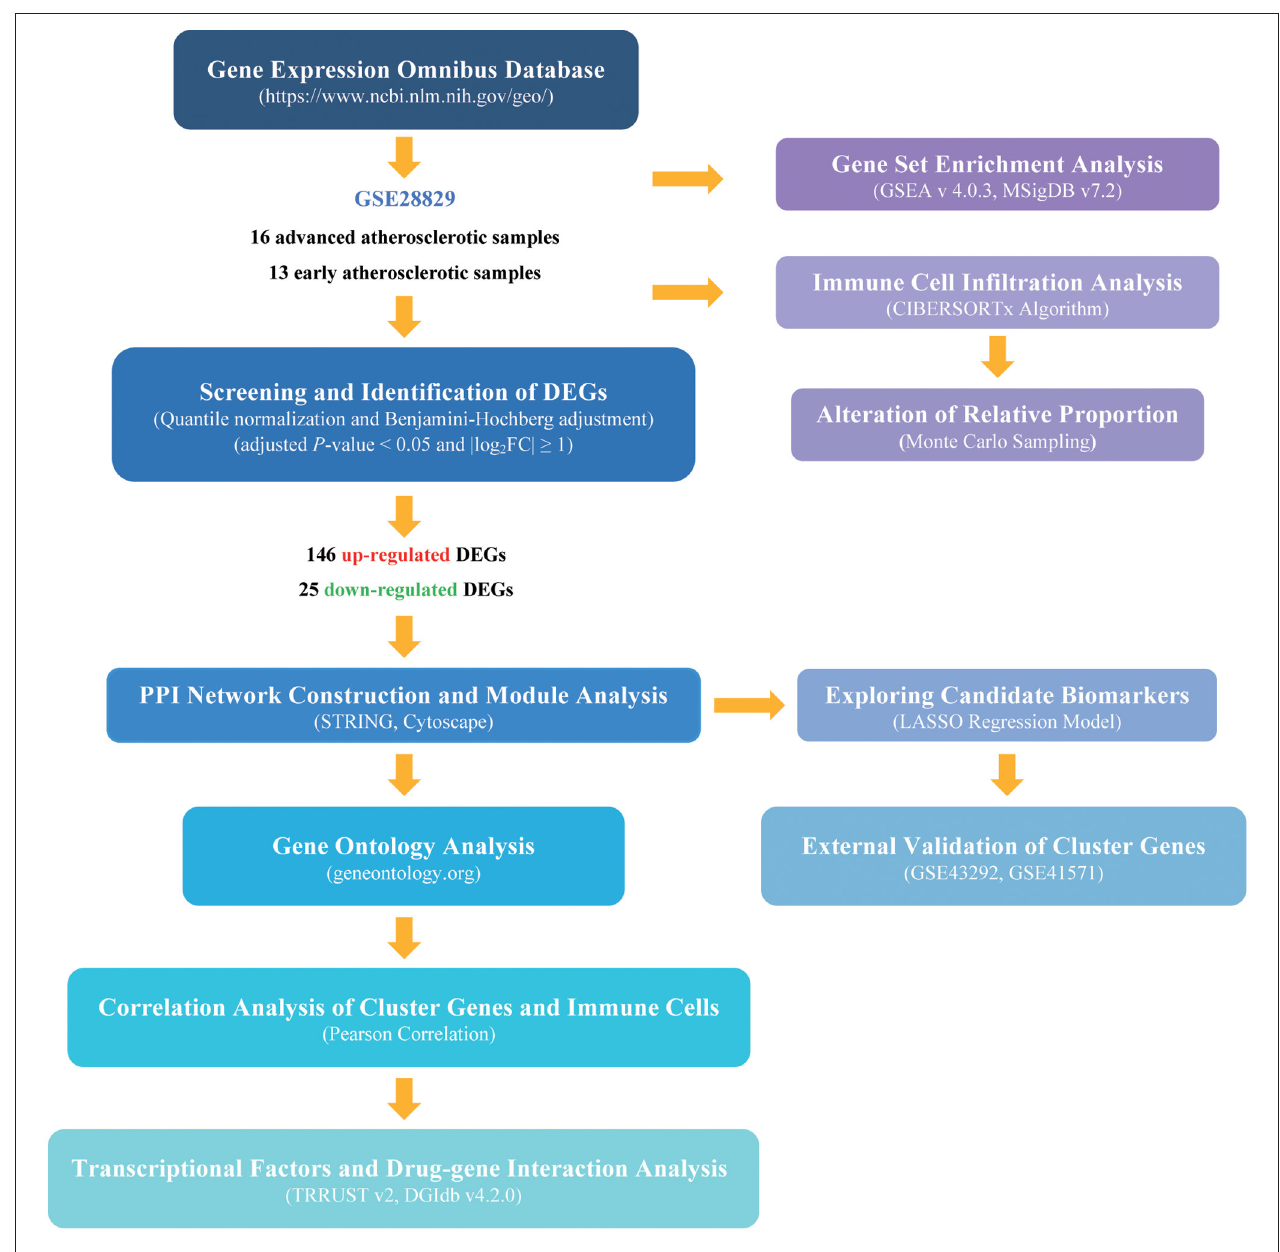
FIGURE 1 | The flowchart of the analysis procedure. The detailed information was described in the materials and methods section.